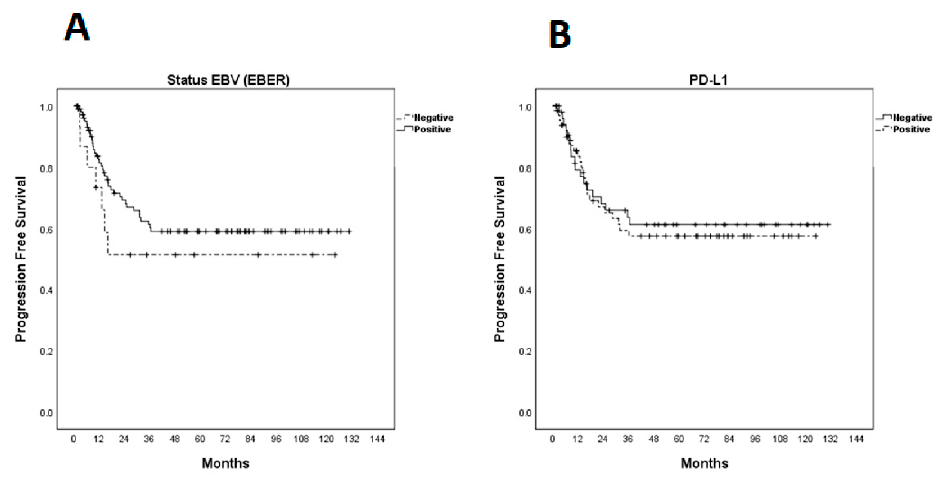
Figure 3. Kaplan–Meier curves for progression-free survival (PFS). ( A ) PFS according to EBER (Epstein–Barr-virus-encoded small RNAs); ( B ) PFS according to programmed cell death ligand-1 expression.